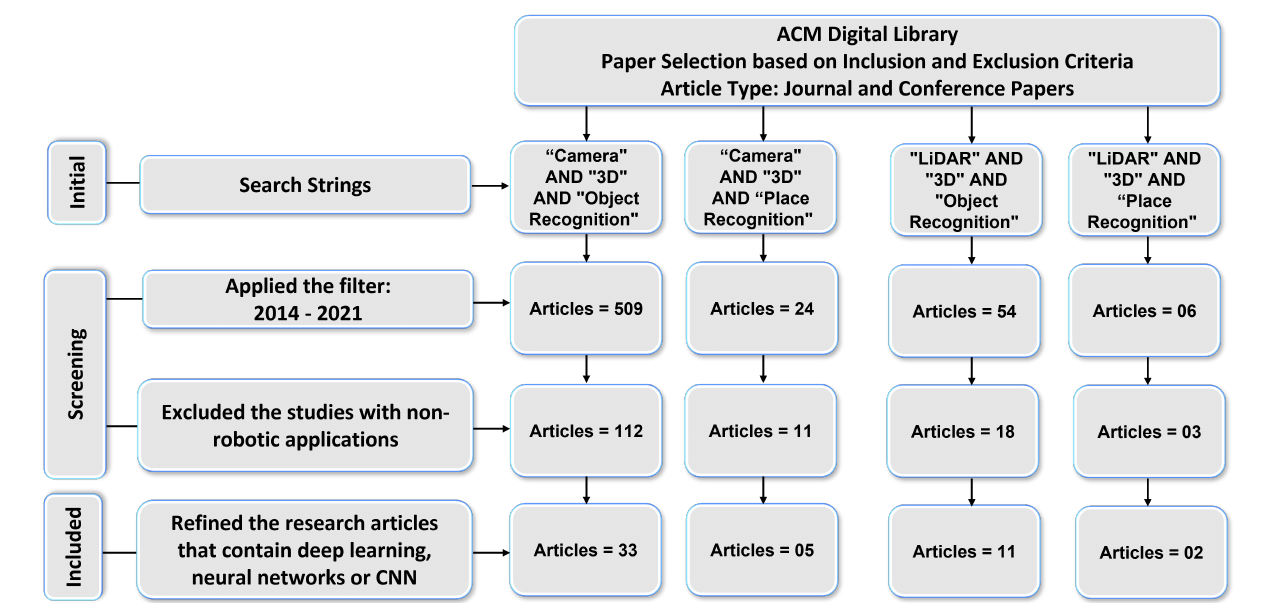
Figure 3. Results: ACM Digital Library paper selection based on the inclusion and exclusion